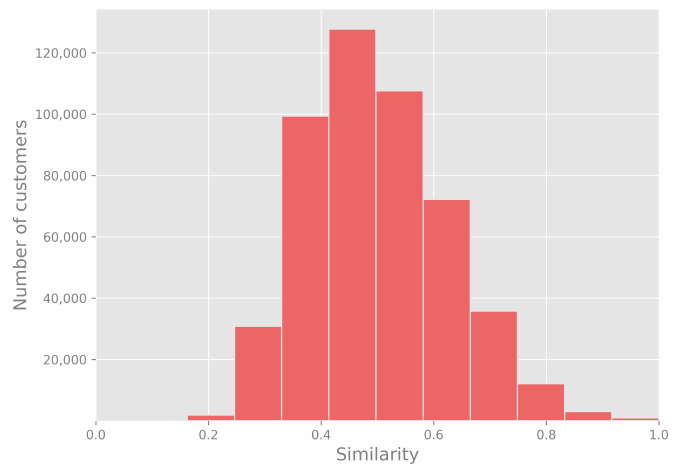
Figure 4. Histogram of scaled cosine similarity for the dataset of resellers.